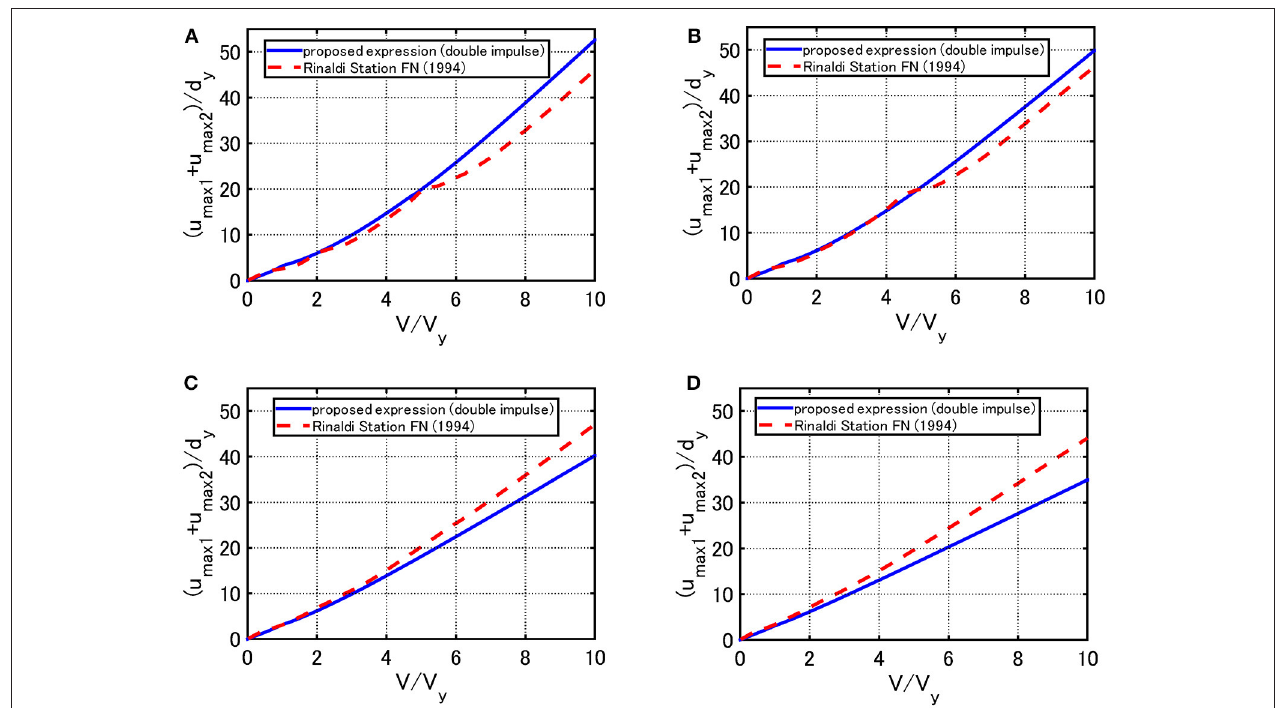
FIGURE 12 | Maximum amplitude of deformation for the recorded ground motion (Rinaldi station fault-normal component) and the proposed one: (A) 10-story model (Soil type 1), (B) 10-story model (Soil type 3), (C) 20-story model (Soil type 1), (D) 20-story model (Soil type